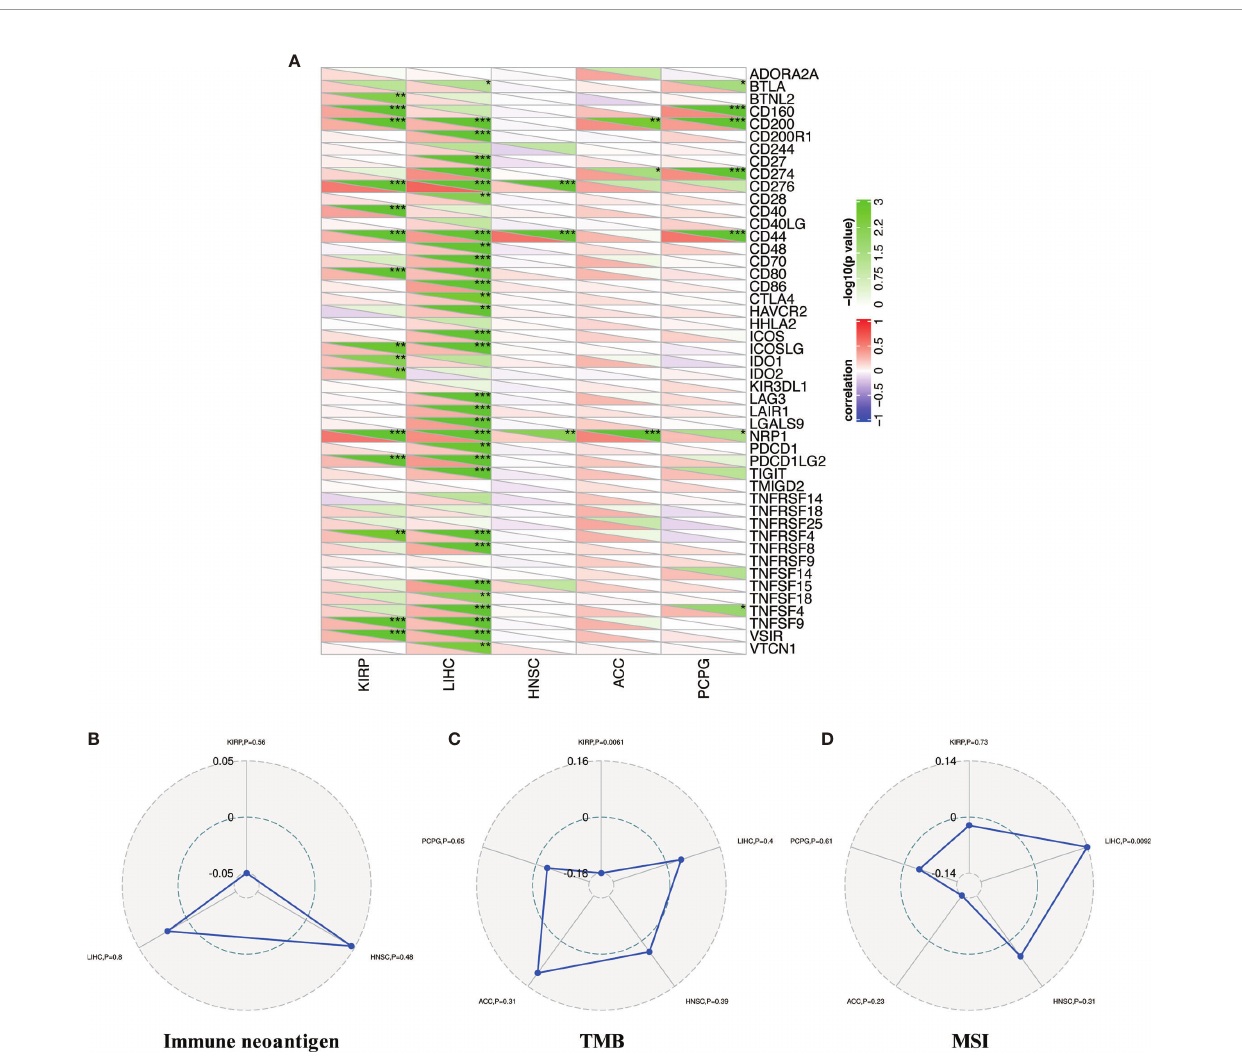
FIGURE 6 | Relationship between NAT10 expression and immune checkpoint gene expression, immune neoantigens, TMB, and MSI in ACC, HNSC, KIRP, LIHC, and PCPG. (A) Correlations of NAT10 expression with immune checkpoint gene expression. The lower triangle in each tile indicates coef fi cients calculated by Pearson ’ s correlation test, and the upper triangle indicates the log10-transformed P-value. (B) Correlations between immune neoantigens and NAT10 expression. (C) Correlations between TMB and NAT10 expression. (D) Correlations between MSI and NAT10 expression. *P < 0.05, **P < 0.01, ***P <